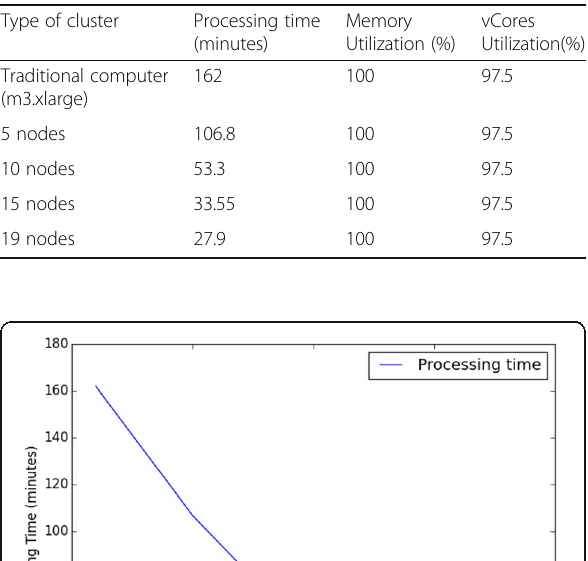
Table 5 Processing times of each different clusters